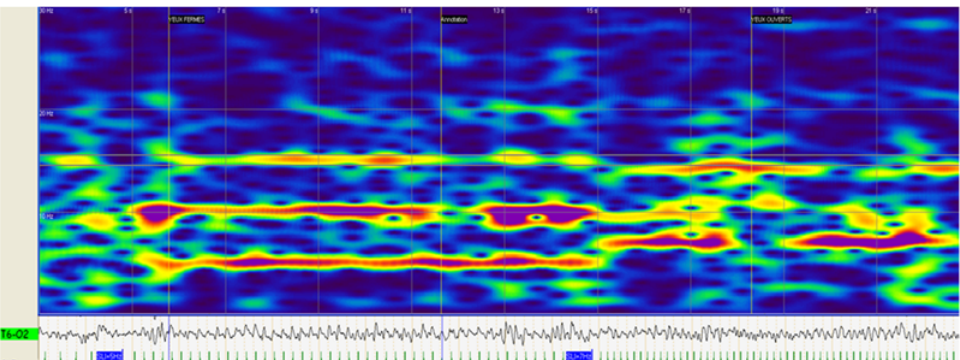
Figure 1. Time–frequency analysis through continuous wavelet transform.